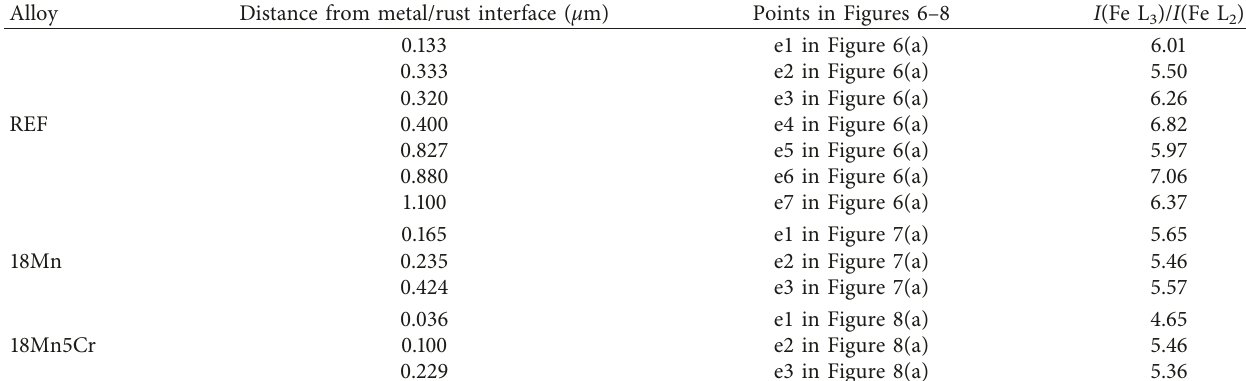
3 edge peak to Fe L 2 edge peak depending on various positions among rust formed on